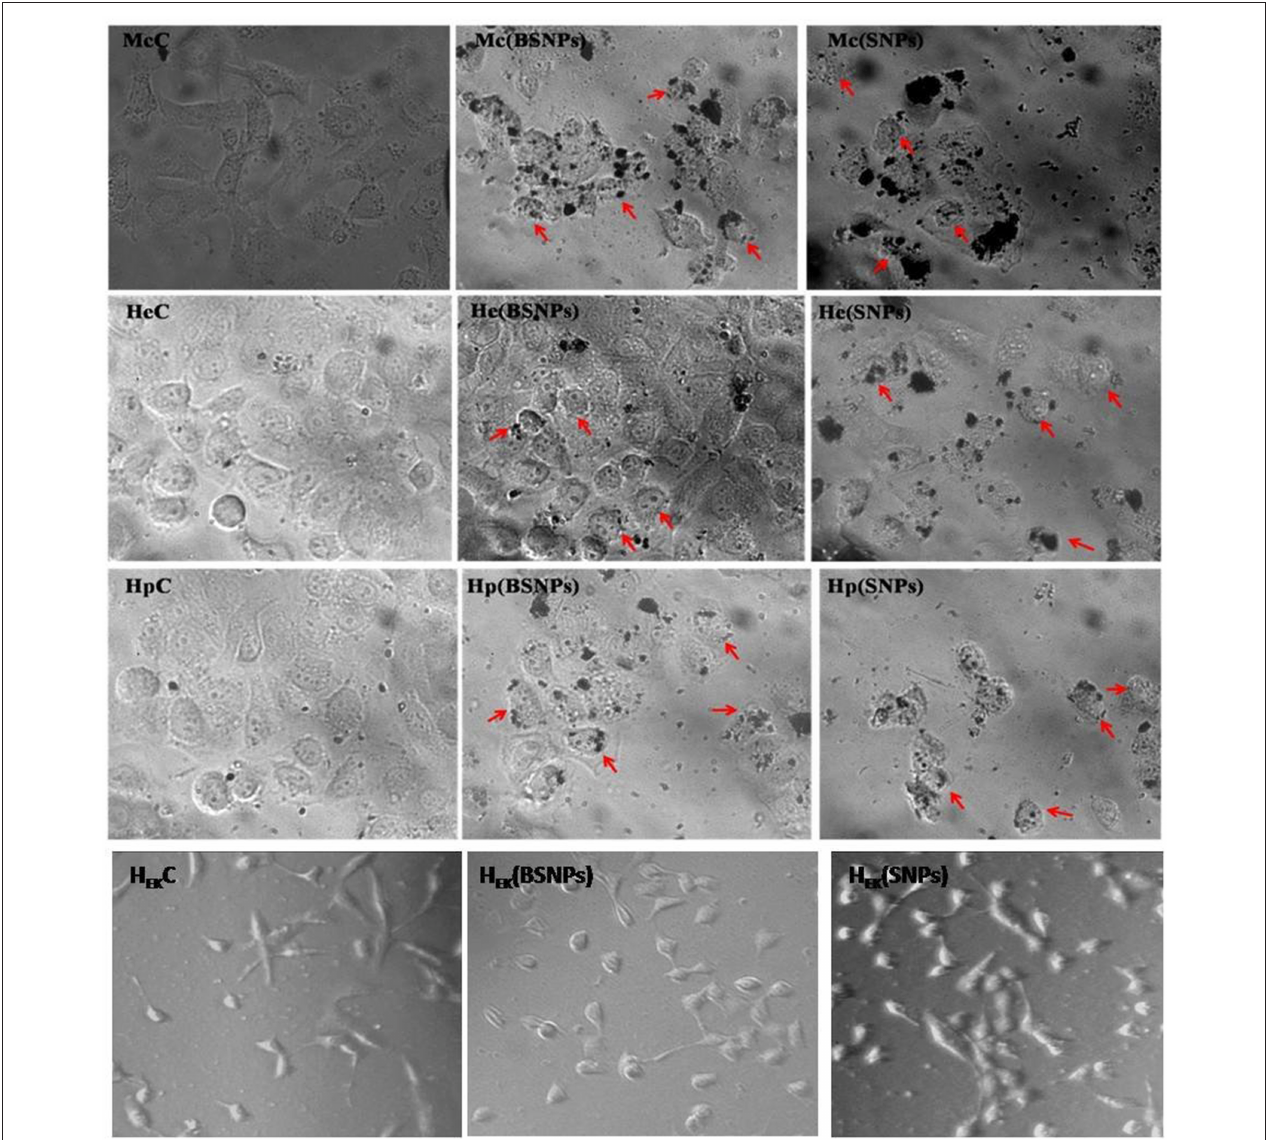
FIGURE 6 | Cytotoxic activity of biogenic synthesized silver nanoparticles at IC 50 against different cancer cell line Mc (MCF 7), He (HeLa), Hp (HepG2), H EK (HEK-293), C (control), BSNPs (Biogenic Silver nanoparticles) and SNPs (Chemically synthesized silver nanoparticles).